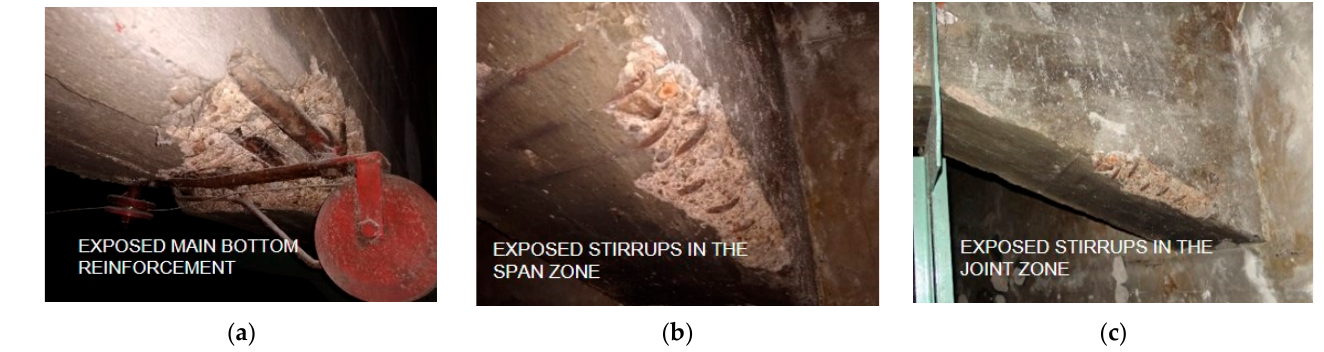
Figure 8. Excavations on beam’s surface: ( a ) at the point where the main reinforcement bars are connected to the winch; ( b ) at the point of insufficient cover in the beam span; ( c ) at the point of insufficient cover in the bevel.